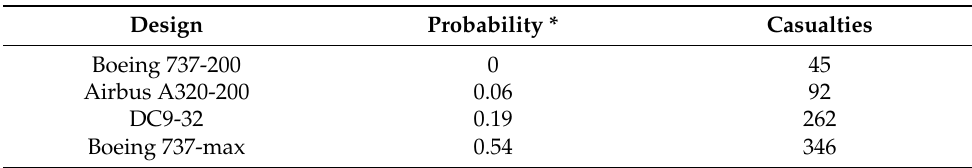
Table 1. Cumulative probability with Boeing 737-Max in the